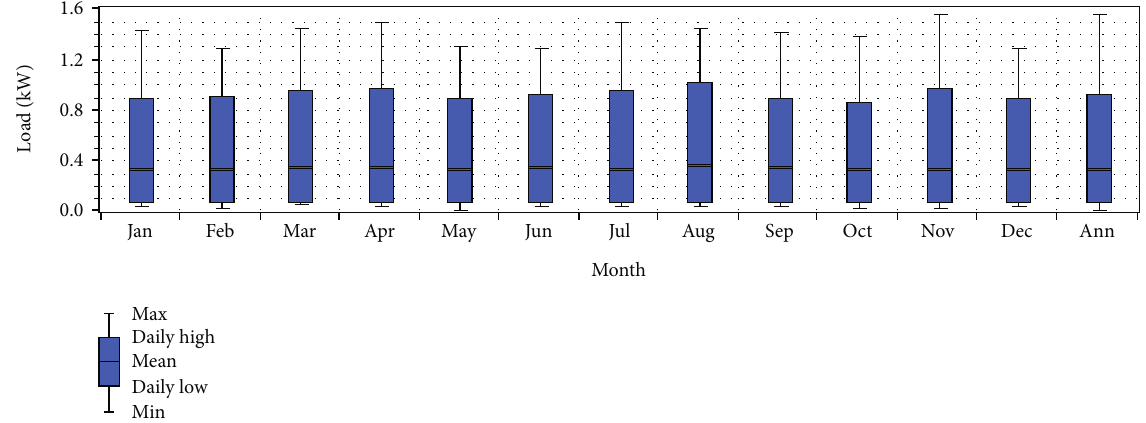
Figure 5: Annual consumption after applying random Table 3: Input required data.